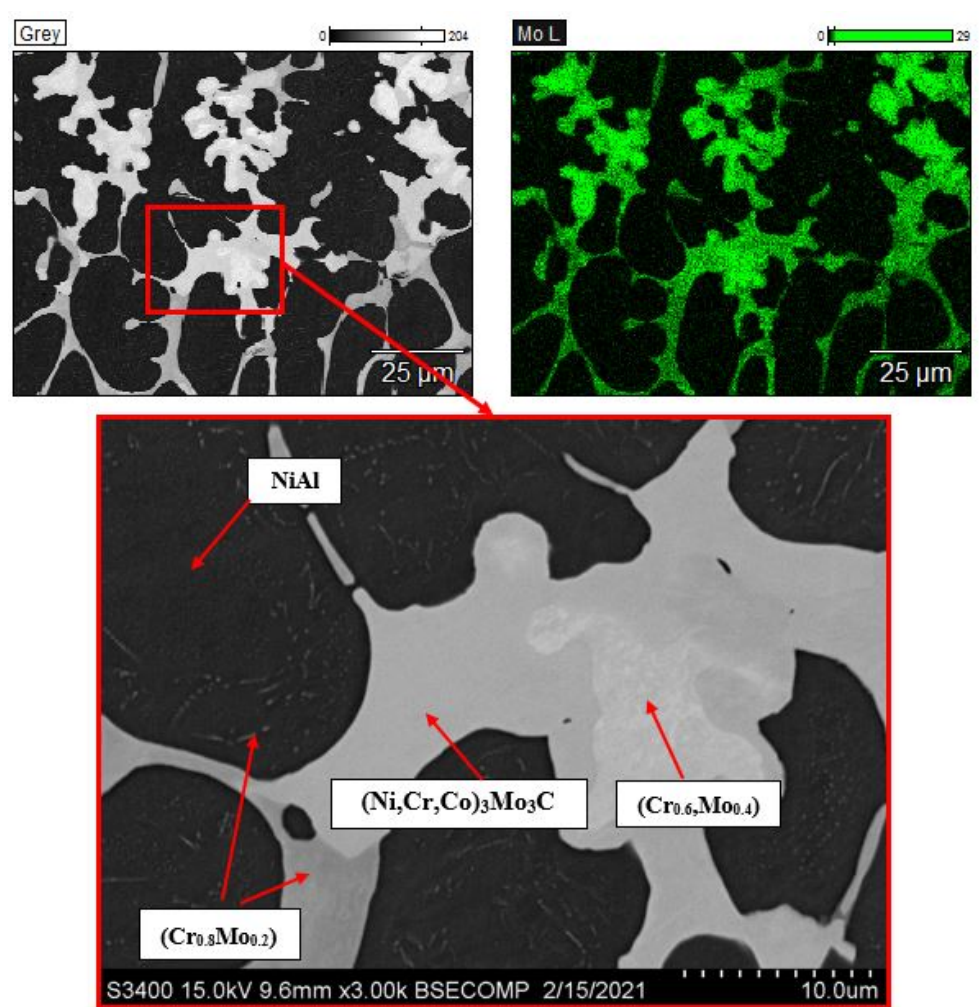
Figure 11. The microstructure of the alloy doped with 15% molybdenum and the map of doping element distribution. element